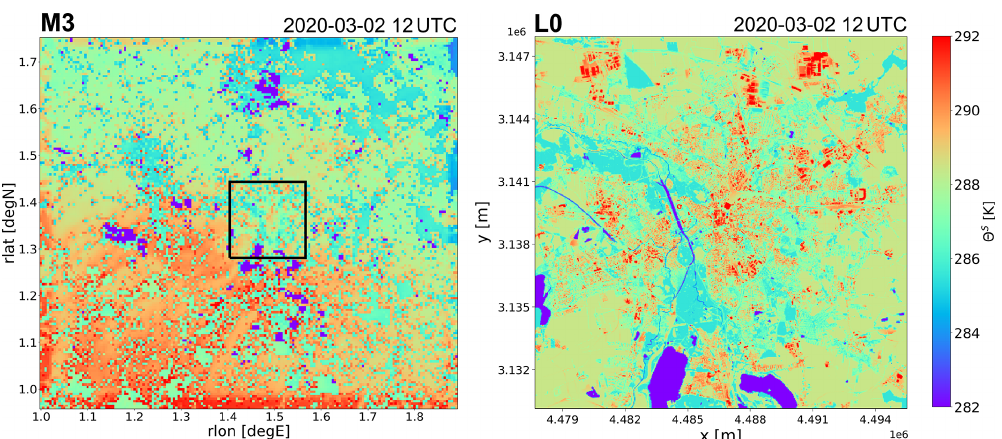
Figure 7. Diagnostic (cid:50) S downscaling from the mesoscale COSMO-MUSCAT domain M3 to the urban-microscale CAIRDIO domain L0 as by the explained land-cover method in Sect.